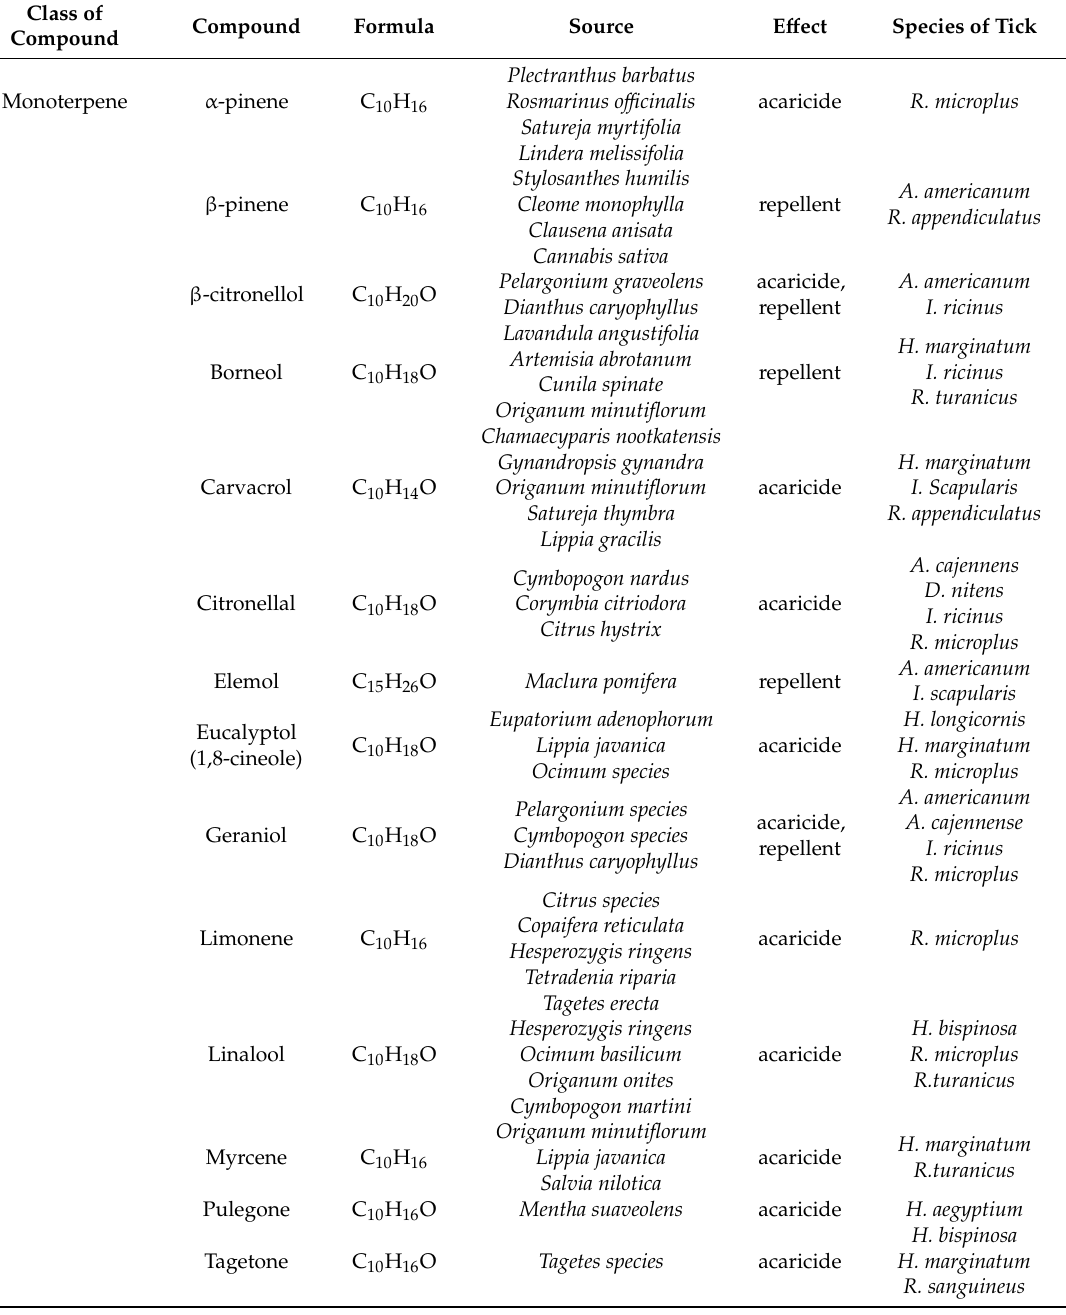
Table 3. Plant-derived compounds with potential for tick control and